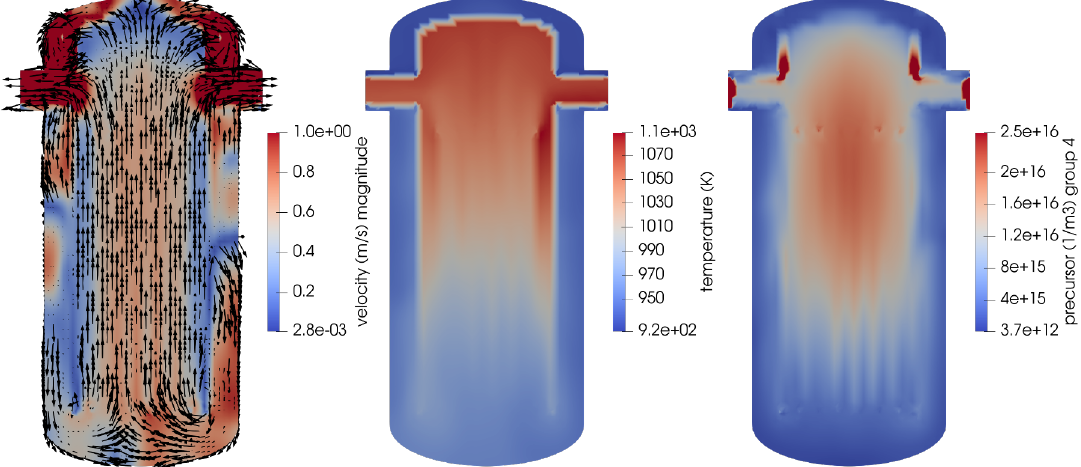
Figure 4: Velocity and velocity-dependent fields of temperature and delayed neutron precursor in group